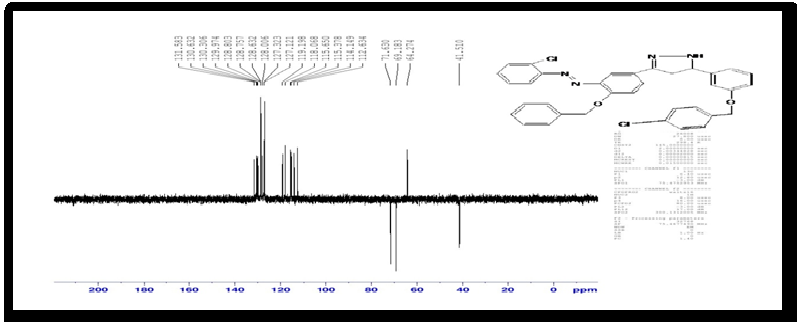
Figure 3: 13 C-NMR spectrum of compound (4j).